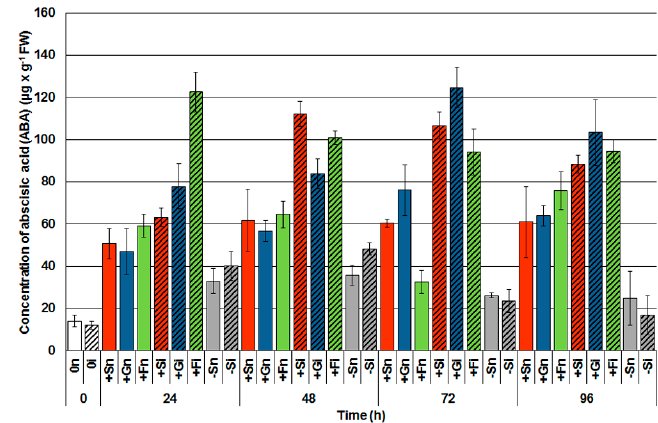
Figure 2. Effect of sucrose, glucose and fructose on the accumulation of abscisic acid (ABA) in in vitro cultured embryo axes of Lupinus luteus infected with Fusarium oxysporum f. sp. lupini . A summary of the statistical significance of differences between the average values of each pair at p < 0.05 can be found in the Supplementary Files (Table S4).